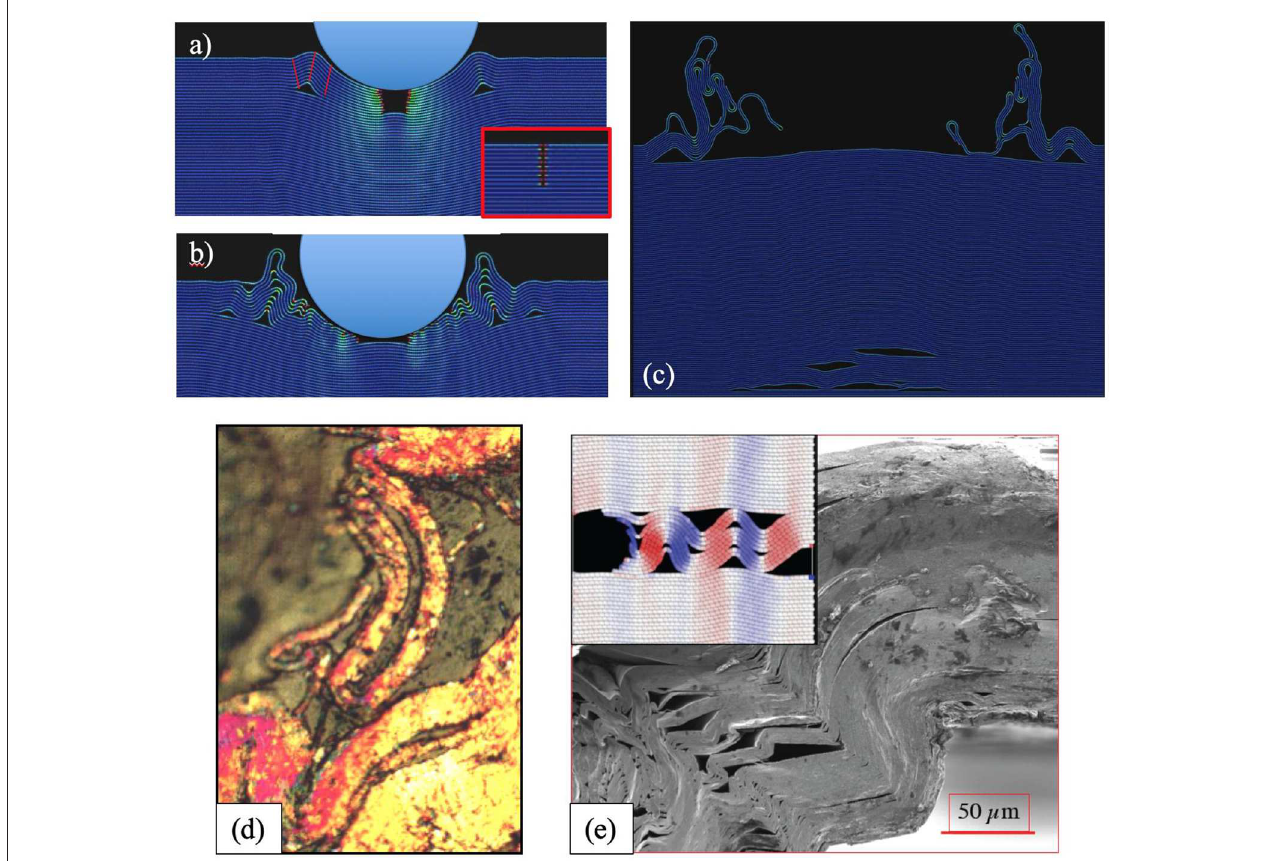
FIGURE 10 | (a) Freeze-frames from MD simulation of graphitic basal planes loaded along [0001] with a cylindrical indenter at, (a) intermediate penetration where two kink bands—comprising three kink boundaries denoted with short red lines form on either side of the indenter. Note delaminations. Inset shows initial configuration in which the 10 topmost layers are severed before loading (Griggs et al., 2017). (b) Higher penetration and, (c) after complete unloading. Note permanent delaminations cracks near the bottom of the frame. (d) Optical microscope micrograph of a single Ti 3 SiC 2 grain deformed at room temperature when a cube was loaded in compression (Barsoum and El-Raghy, 1999). Etching imparts the vivid colors seen; the brown background is that of the mounting epoxy. (e) SEM micrograph Cr 2 AlC single crystal that was deformed at high temperatures with minimal constraints. Inset shows what occurs to graphite layers that were compressed with no side constraints, i.e., by allowing layers to move freely in vertical direction (Barsoum et al., 2019). (a–c) Reproduced with permission from Acta Materialia, Elsevier. (d) Reproduced with permission from Metallurgical and Mater. Trans. A, Springer Nature.